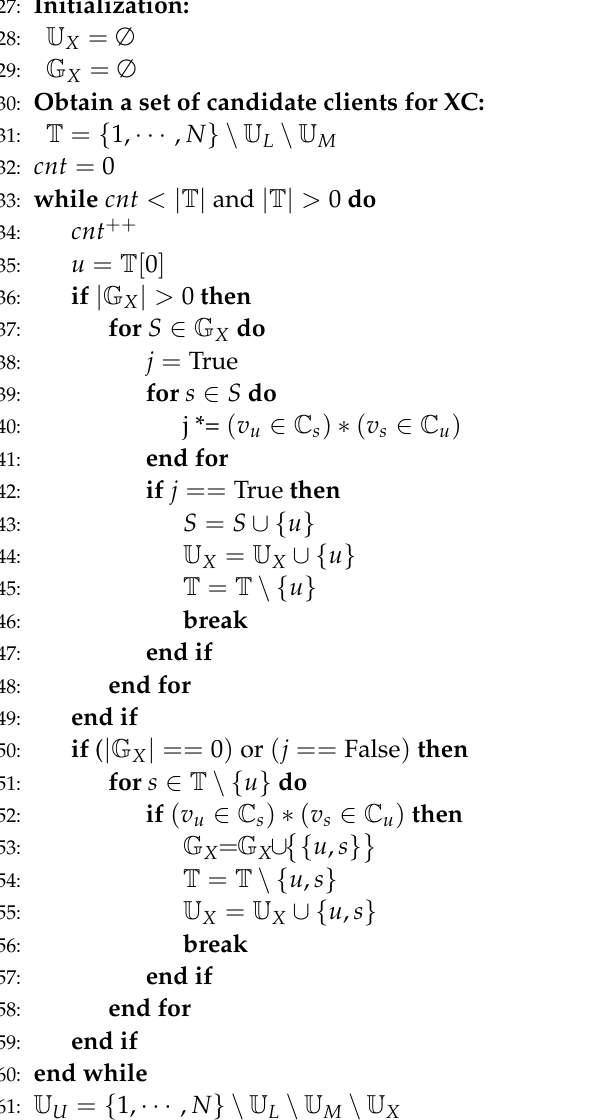
Algorithm 2 Proposed Video Streaming: Phase 2. XC and